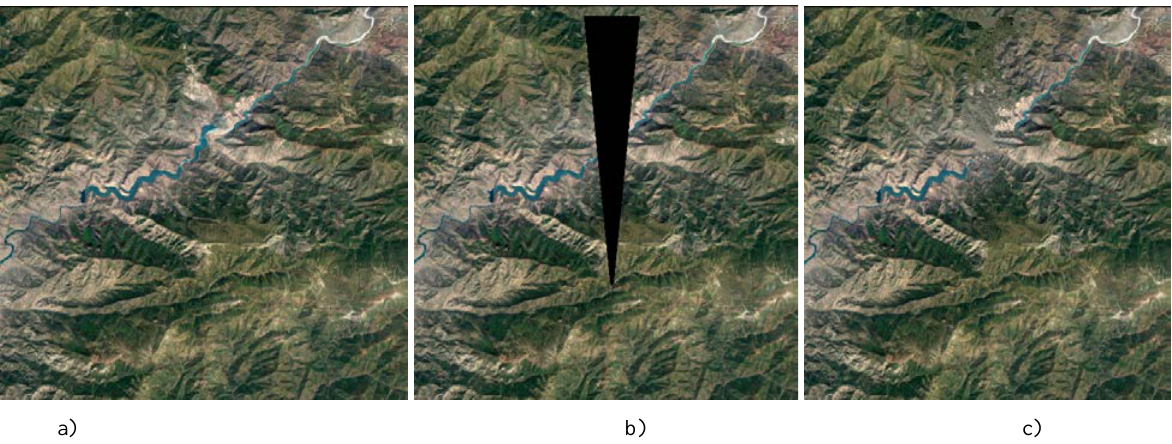
Fig. 5 . The result of the method: a) original image, b) the image, with a mask of the distorted pixels, c) image, reconstructed by the proposed